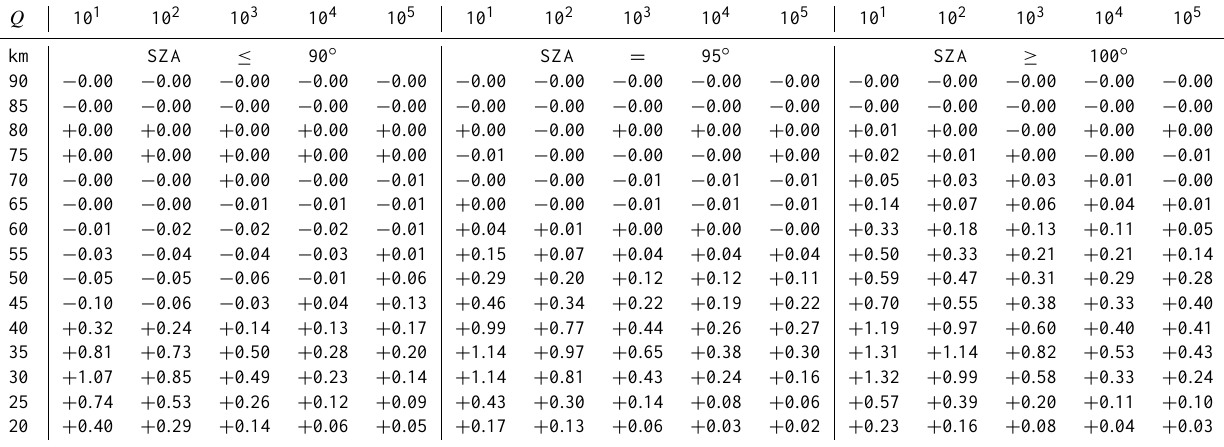
/Q for January NH. 3